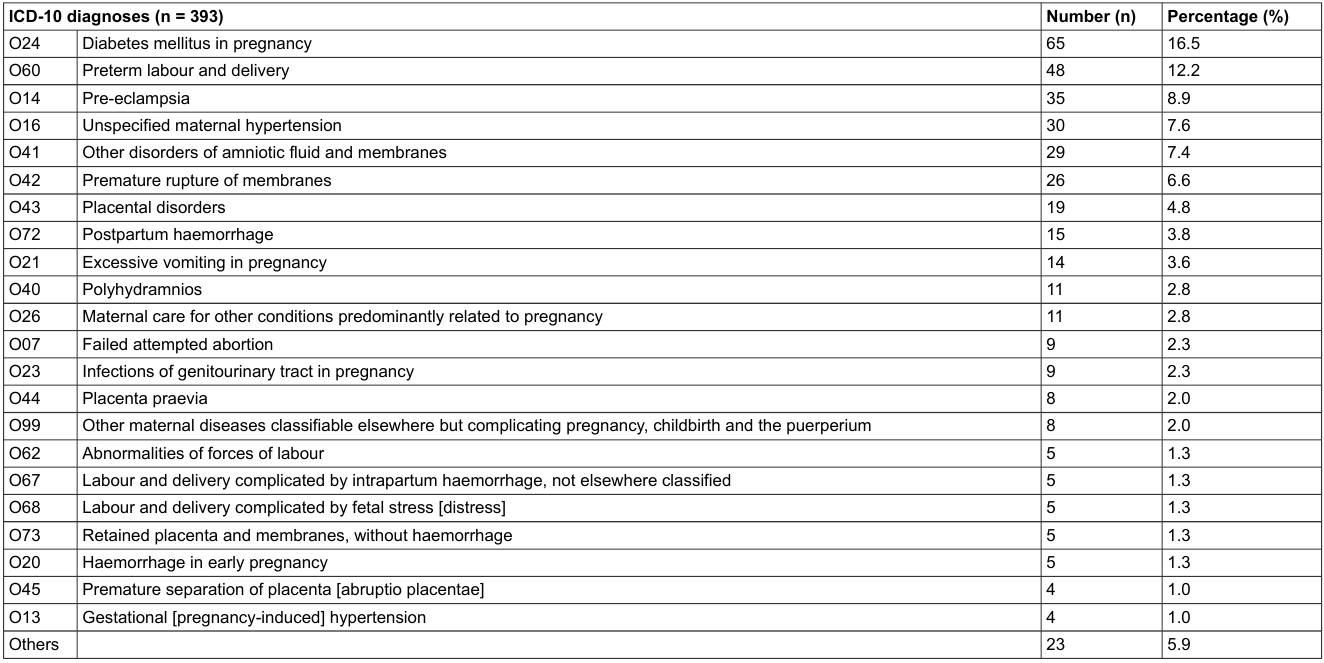
Table 3: ICD-10 categories for obstetric outcome after an exposure to at least one medication during a singleton pregnancy. ICD-10 diagnoses (n = 393)